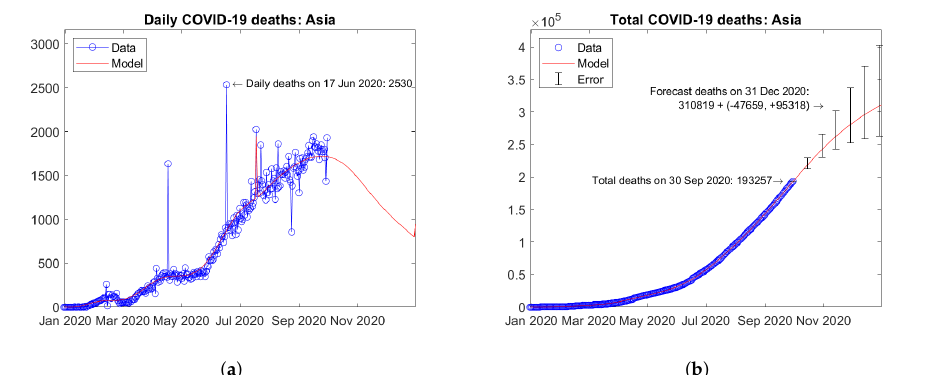
Figure 9. Actual and predicted trends in Asia: ( a ) total deaths; ( b ) daily deaths.